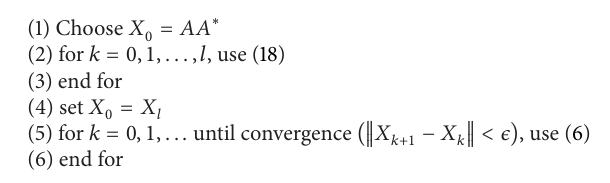
Algorithm 1: A hybrid method for computing the minimal HPD solution of (1).